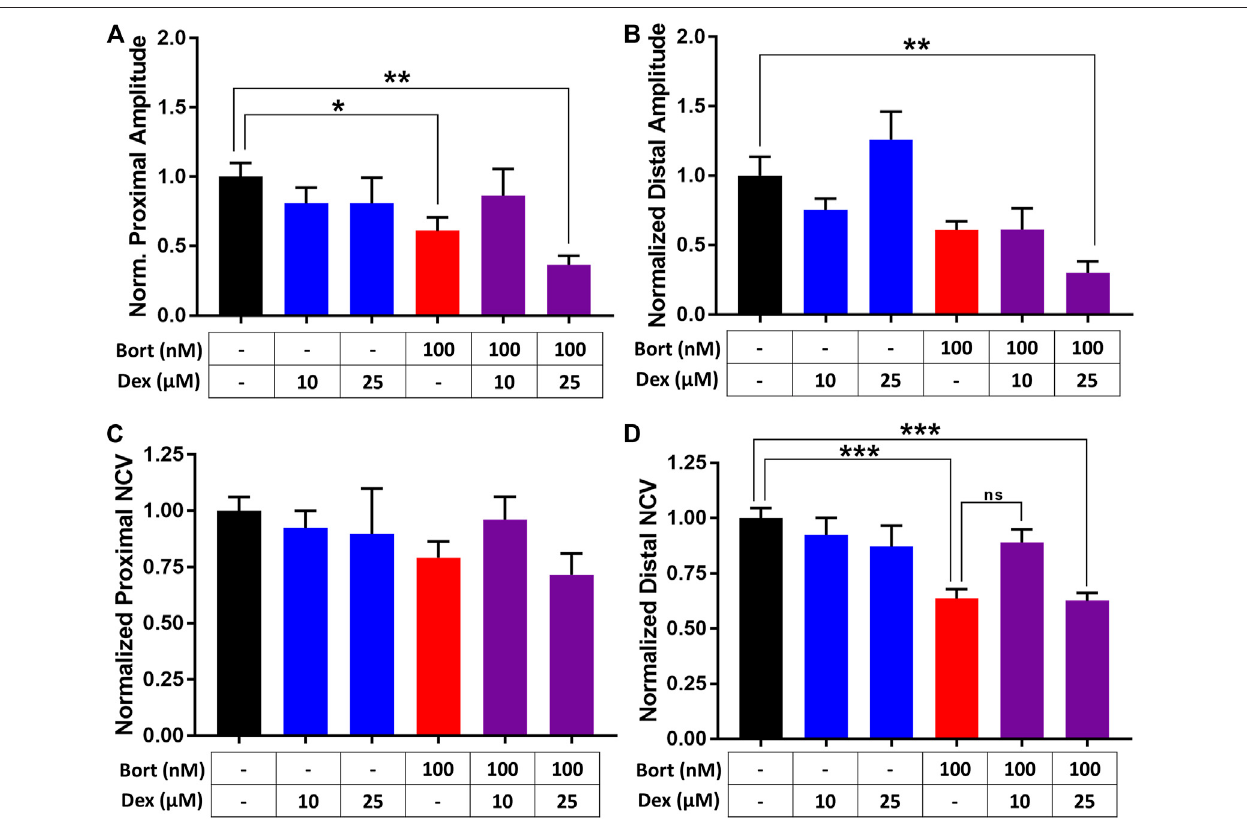
FIGURE3| Assessmentofdexanabinolneuroprotectiveeffectsusingnerve-on-a-chip.Theeffectofdexanabinolonbortezomib-induceddecreasesin (A) proximal action potential amplitude (APA), (B) distal action potential amplitude, (C) proximal nerve conduction velocity, and (D) distal nerve conduction velocity. Action potential amplitudesandnerveconductionvelocitywerenormalizedtotreatmentnaïvecontrol(black).Dexanabinol(10and25 μ M),bortezomib(100 nM),andthecombinationof both drugs are displayed as blue, red, and purple bars. GraphPad prism v7.04 was used to perform a one-way ANOVA with Tukey ’ s correction for multiple comparisons acrossall groups. Only signi fi cant comparisons tocontrolare displayed. p values arereported as:ns (not signi fi cant), * ( < 0.05),** ( < 0.01), and *** ( <